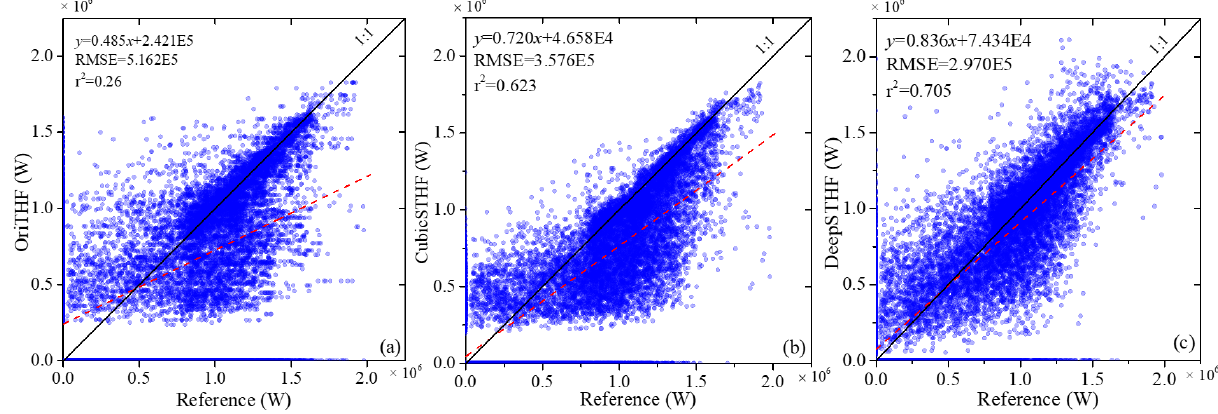
Figure 10. Scatter plots of the THF calculated from the reference data and the THF estimated by (a) the OriTHF method, (b) the CubicSTHF method, and (c) the DeepSTHF method. The red dashed lines denote the fitted linear regression lines of the data points. RMSE and r denote the root-mean-square error and Pearson coefficient,